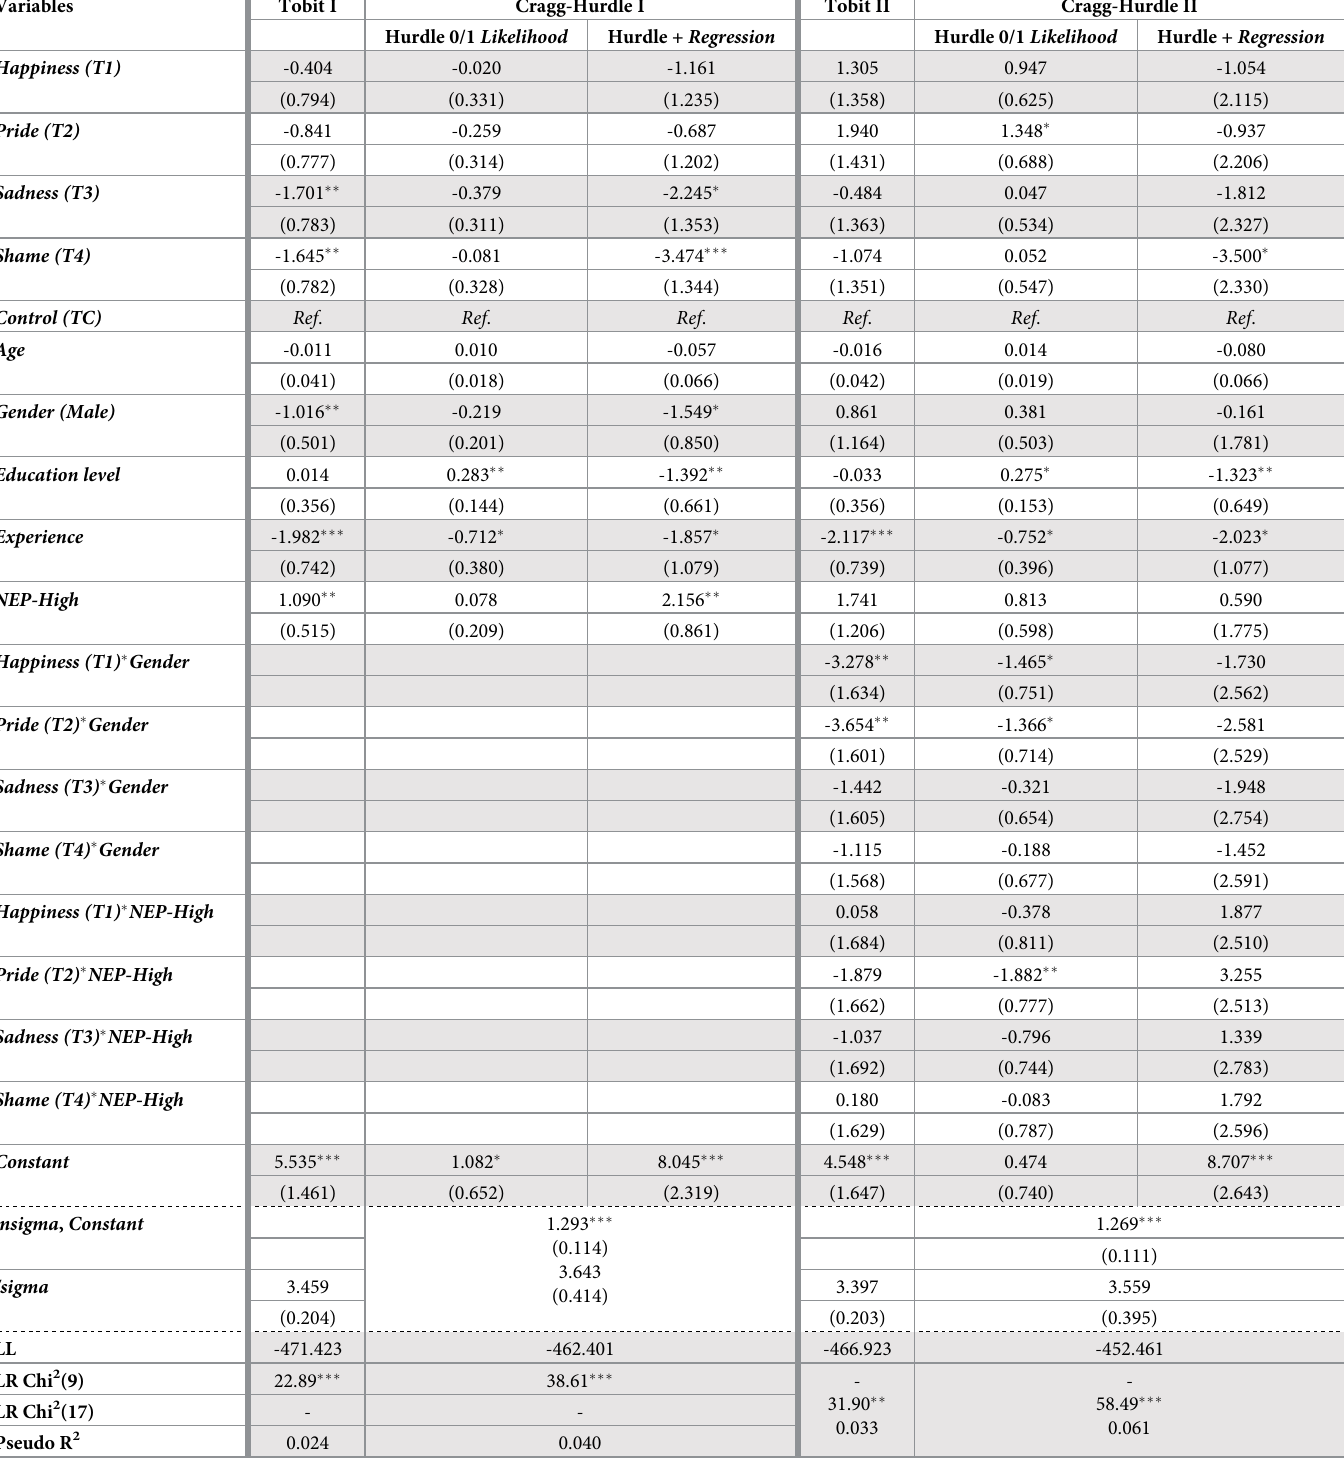
Table 8.1. Treatment effects, intensive and extensive margins of monetary donation/separate emotional